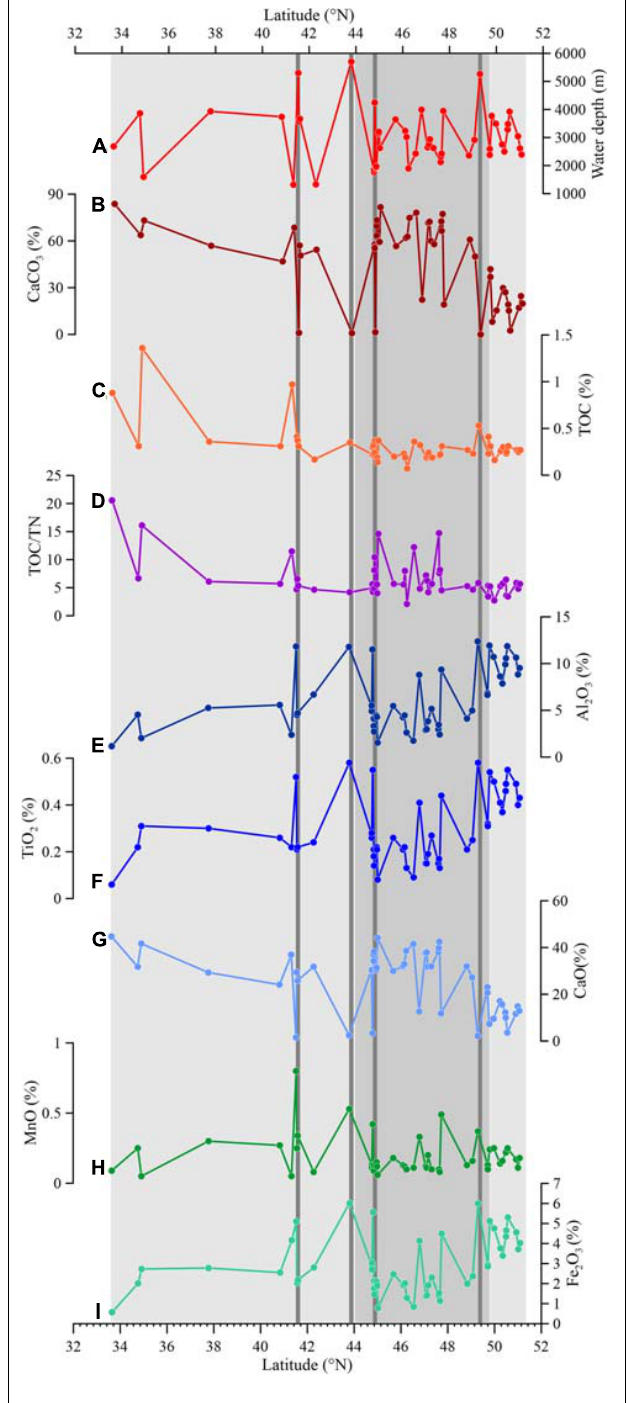
FIGURE 4 | Spatial variations in the contents of major elements in the study area. The dark black vertical lines indicate stations with water depth greater than 4,000 m. The spatial variation of water depth (A) , spatial variation in the content of CaCO 3 (B) , spatial variation in the content of TOC (C) , spatial variation in the content of TOC/TN (D) , spatial variation in the content of Al 2 O 3 (E) , spatial variation in the content of TiO 2 (F) , spatial variation in the content of CaO (G) , spatial variation in the content of MnO (H) and spatial variation in the content of Fe 2 O 3 (I)